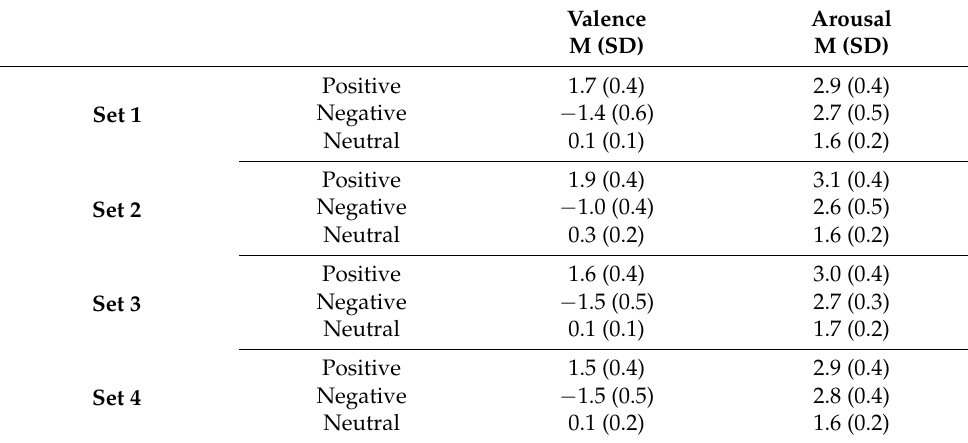
Table 4. Subjective valence and arousal ratings for all four sets (parallel versions) of the EMOBACK